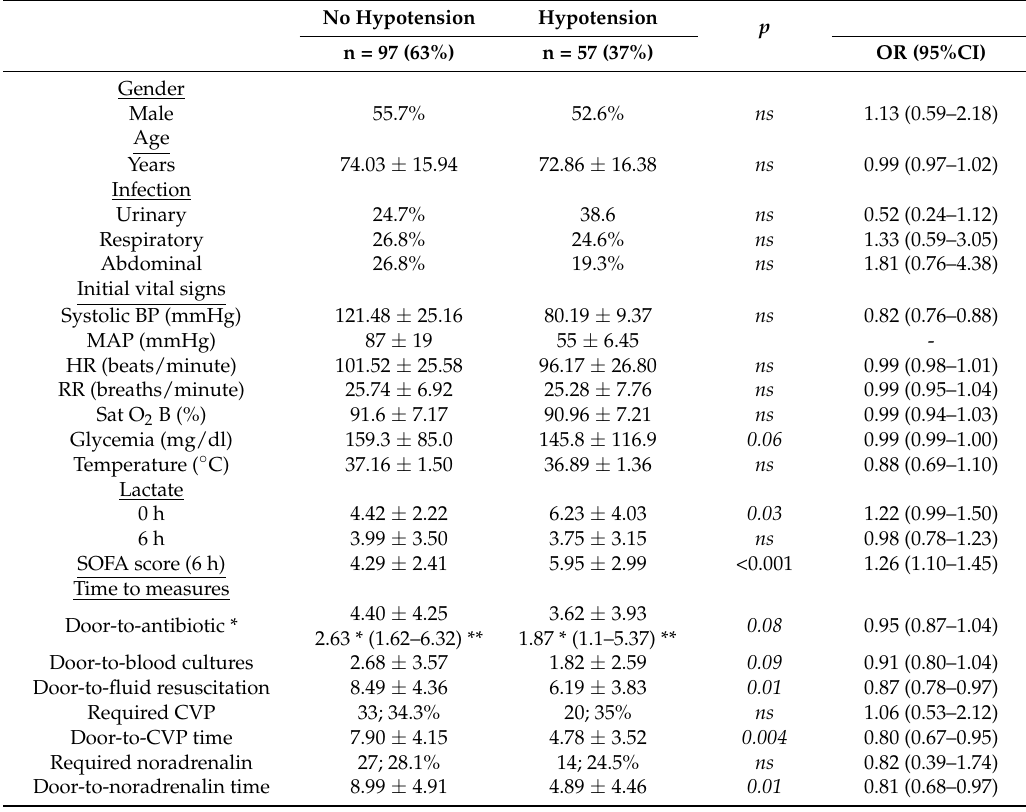
Table 2. Main epidemiological and clinical variables depending on the presence or absence of hypotension. Differences in response time (in hours), from the time of admission to the emergency department, for patients with initial hypotension versus those